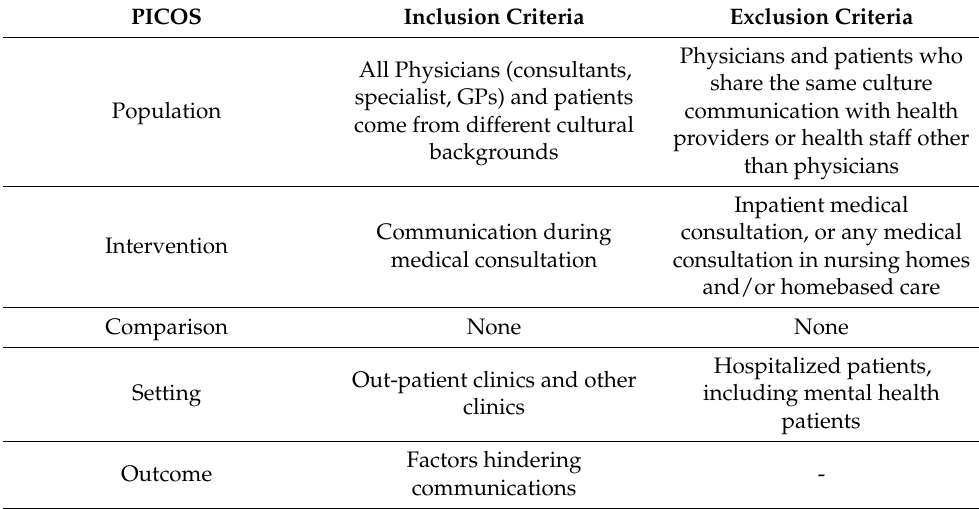
Table 1. The inclusion and exclusion criteria of the study participants is as follows. PICOS Inclusion Criteria Exclusion Criteria Physicians and patients who All Physicians (consultants, share the same culture specialist, GPs) and patients communication with health Population come from different cultural providers or health staff other backgrounds than physicians Inpatient medical Communication during consultation, or any medical Intervention consultation in nursing homes medical consultation and/or homebased care Comparison None None Hospitalized patients, Out-patient clinics and other Setting including mental health clinics patients Factors hindering Outcome communications